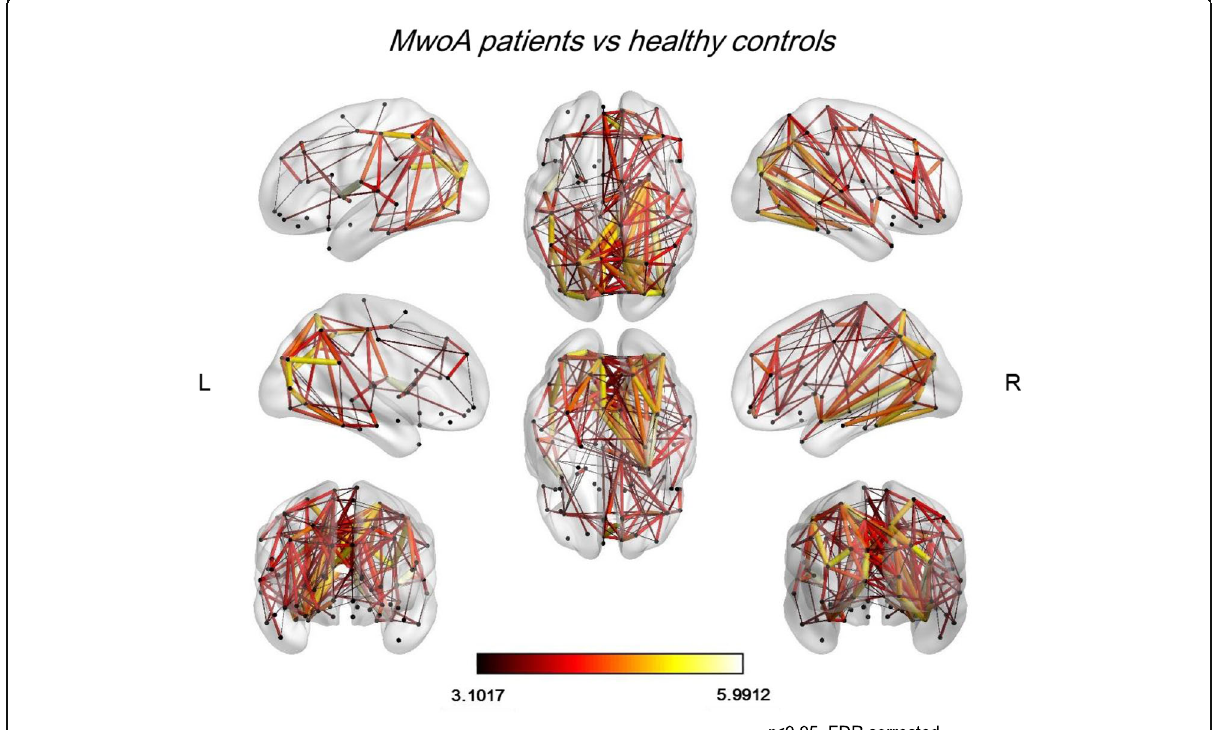
Fig. 3 Representation of nodes and edges with significantly higher connection probability ( t score) in MwoA patients compared to HC data sets ( p < 0.05 corrected for multiple